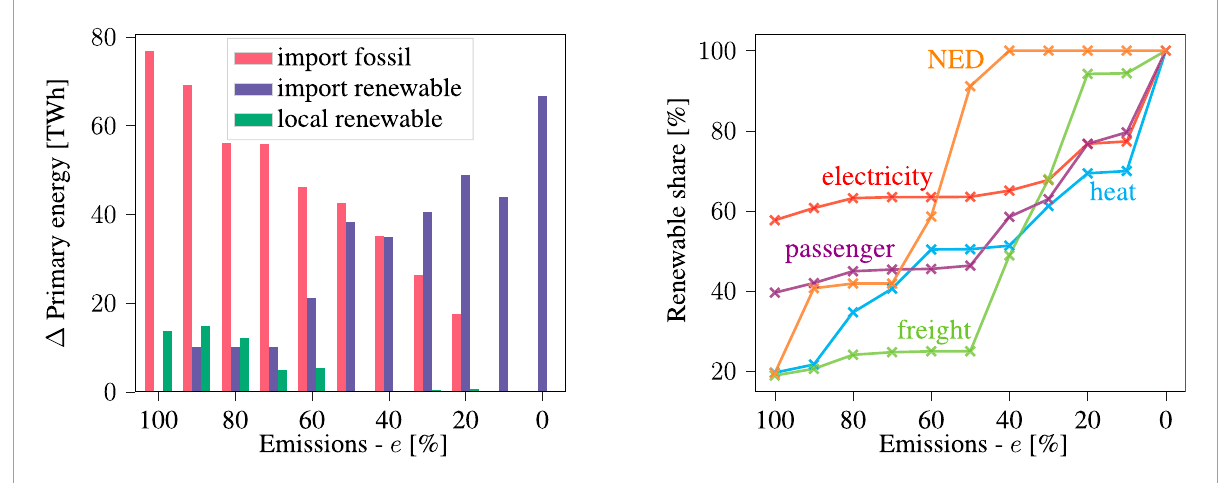
FIGURE 2 (Left) Difference in terms of primary energy consumed between the model with and without the non-energy demand among the end-uses that the optimization has to satisfy. The primary energy demand is split into energy imported via fossil-based resources (import fossil), energy imported produced with renewable resources (import renewable), and energy produced based on the local availability of renewable resources (local renewable). (Right) Share of renewable resources per end-use demand.